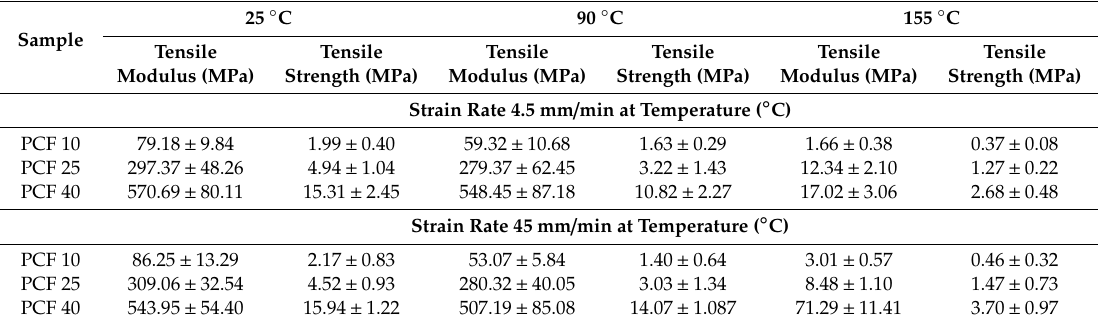
Table 4. Summary of the tensile tests results obtained at a strain rate 4.5 mm / min and 45 mm /